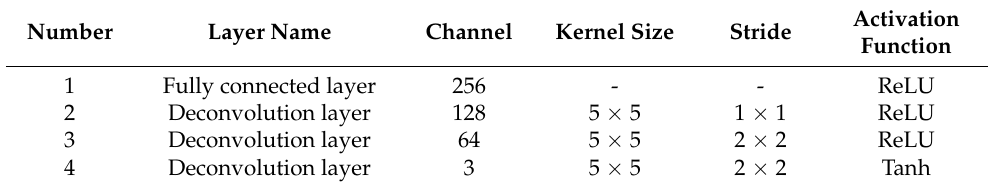
Table 1. Structure of generative model.